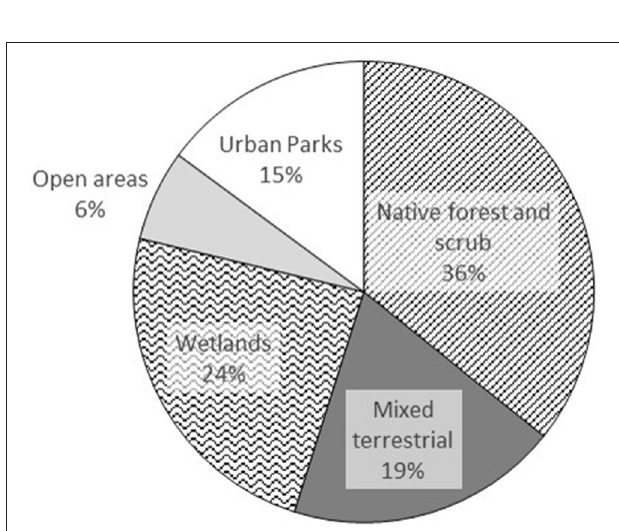
FIGURE 5 | Species accumulation curve and number of species/year registered at the Sabana de Bogotá Audubon’s Christmas Bird Count circle between 1989 and 2014.